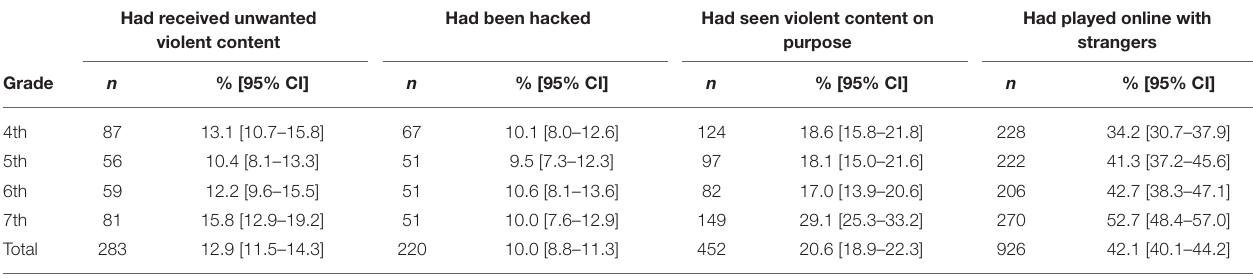
TABLE 4 | Online risk experiences by grade ( n = 2,198; Missing data = 242).